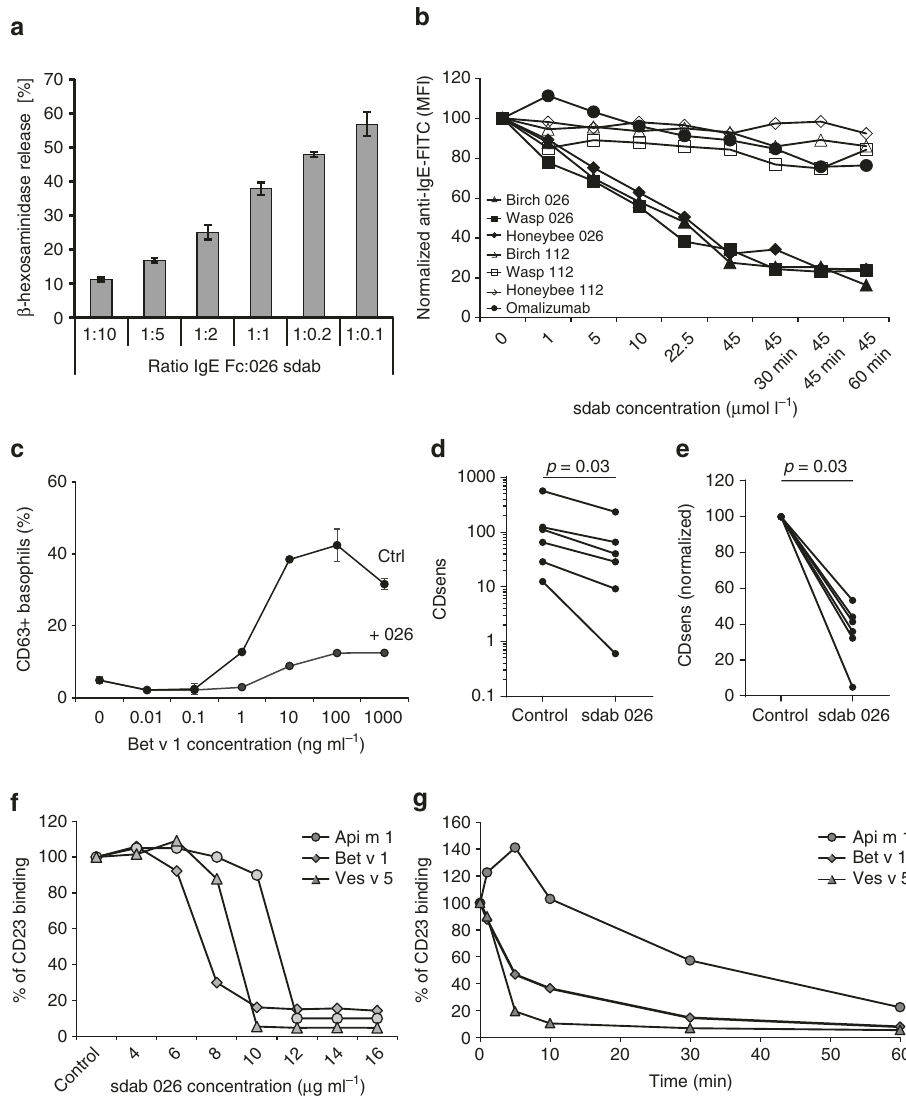
Fig. 4 Functional activity of the sdab. a Inhibition of mediator release from effector cells by 026 sdab was assessed in RBL-SX38 cells providing the human Fc ε RI. Cells were sensitized with IgE Fc in presence of decreasing amounts of 026 sdab. Degranulation was induced by anti-IgE antibody and monitored by released β -hexosaminidase activity. Data are the mean ± standard deviation of triplicate measurements. b Removal of IgE from the surface of basophils by the 026 sdab, the inactive sdab mutant 112 and omalizumab was analyzed by surface staining of IgE using fl ow cytometry. Basophils of three patients with allergy to different major allergens were used. Concentration of omalizumab was identical to sdab concentrations, but doubled to 90 µ mol l − 1 in the prolonged periods. c The capability to reduce basophil sensitivity by displacement of IgE from Fc ε RI was assessed by basophil activation test (BAT). Basophils were incubated with 026 sdab followed by incubation with Bet v 1. Activation of basophils was then assessed by detecting CD63 + basophils in fl ow cytometry (exemplary BAT of one donor included in panel d ). Data are mean ± s.d. d The effect of the 026 sdab on basophil activation was analyzed for six birch pollen-sensitized patients. Reduction of effector cell sensitivity was evaluated by CDsens analysis. Comparison of paired samples ± sdab 026 treatment was done by using the nonparametric Wilcoxon signed-rank test. Differences were considered statistically signi fi cant at p values < 0.05. e Inhibition of IgE binding to CD23 by 026 sdab analyzed by ELIFAB. The binding of allergen:IgE complexes to surface bound CD23 was detected by anti-IgE antibodies. Complexes were formed using sera of allergic patients having highly elevated speci fi c IgE to Api m 1, Bet v 1 and Ves v 5 ( > 100 kUA l − 1 ), respectively. f The displacement of preformed IgE:allergen complexes from CD23 using sera as in panel e by the sdab was analyzed by detecting remaining binding of allergen:IgE complexes after incubation with 026 ( > 100 kUA l − 1 ) against the honeybee venom allergen Api m 1, the birch pollen allergen Bet v 1 and the major yellow jacket venom allergen Ves v 5 were incubated with the respective allergen and the IgE:allergen complexes applied to CD23. The sdab ef fi ciently prevented binding of the IgE:allergen complexes to CD23 (Fig. 4f). Moreover, even when applied after binding of the complexes to CD23, the sdab displaced IgE ef fi ciently within minutes (Fig. 4g).